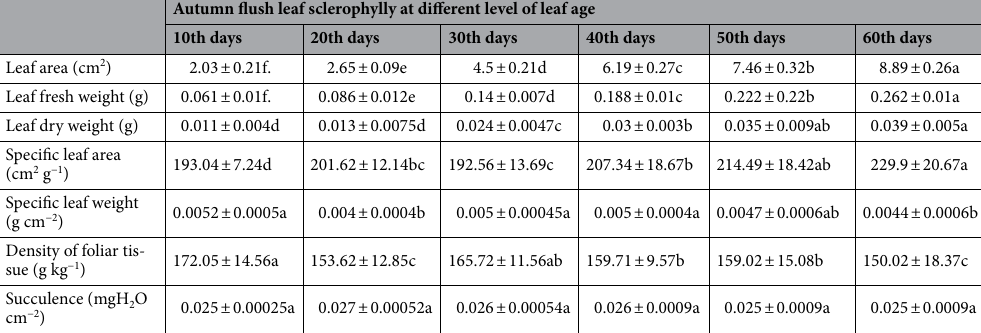
10th, 20th, 30th, 40th, 50th and 60th days of leaf age, respectively. Whereas, leaf area was estimated (2.03, 2.65, 4.5, 6.19, 7.46 and 8.89 cm 2 ) and leaf succulence (0.025, 0.027, 0.026, 0.026, 0.025 and 0.025 mg H 2 O cm −2 ) were recorded in autumn flush at 10th, 20th, 30th, 40th, 50th and 60th days of leaf age, respectively. Both leaf area and succulence decide larva feeding/mining in a leaf while the rest of leaf sclerophylly parameters depend on leaf size and weight, which indirectly indicates the susceptible leaves.